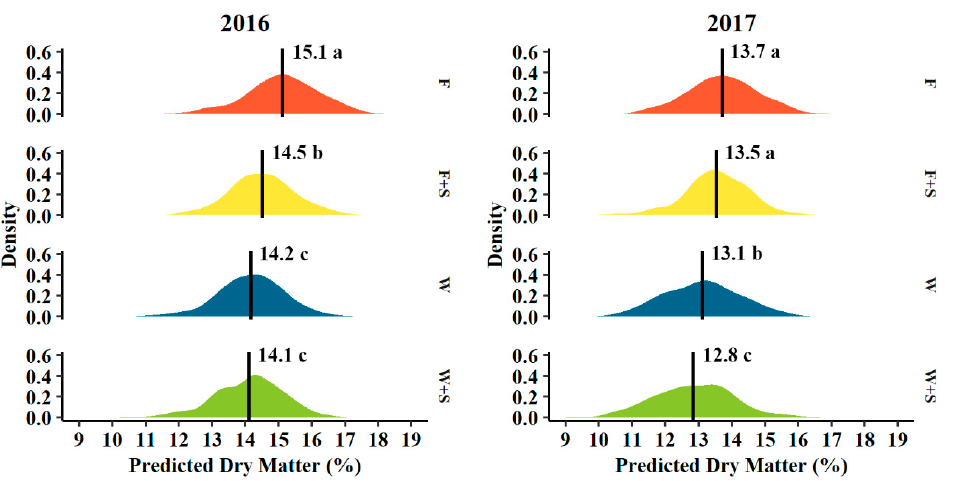
Figure 5. Density distribution of predicted dry matter (%) determined at harvest of 2016 (left) and 2017 (right) fruit grown among seasonal pruning treatments consisting of fall pruning (F, orange, n = 512 and 320 in 2016 and 2017, respectively), fall and summer pruning (F+S, yellow, n = 501 and 320 in 2016 and 2017, respectively), winter pruning (W, blue, n = 500 and 320 in 2016 and 2017, respectively), and winter and summer pruning (W+S, green, n = 500 and 320 in 2016 and 2017, respectively). Vertical lines indicate the average predicted dry matter within each pruning treatment. Different letters indicate significant difference among means across the four pruning treatments in the same year ( p < 0.05, Tukey HSD).